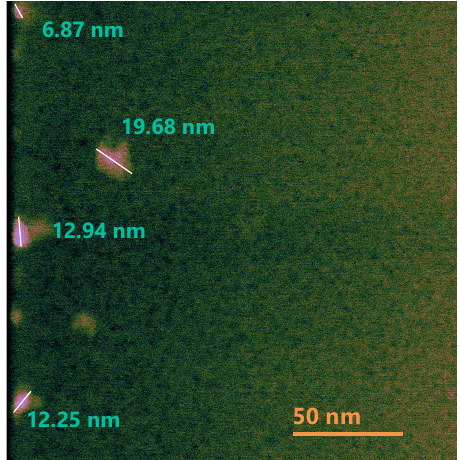
Figure 14. HRTEM micrograph of the A2 SiO x film.